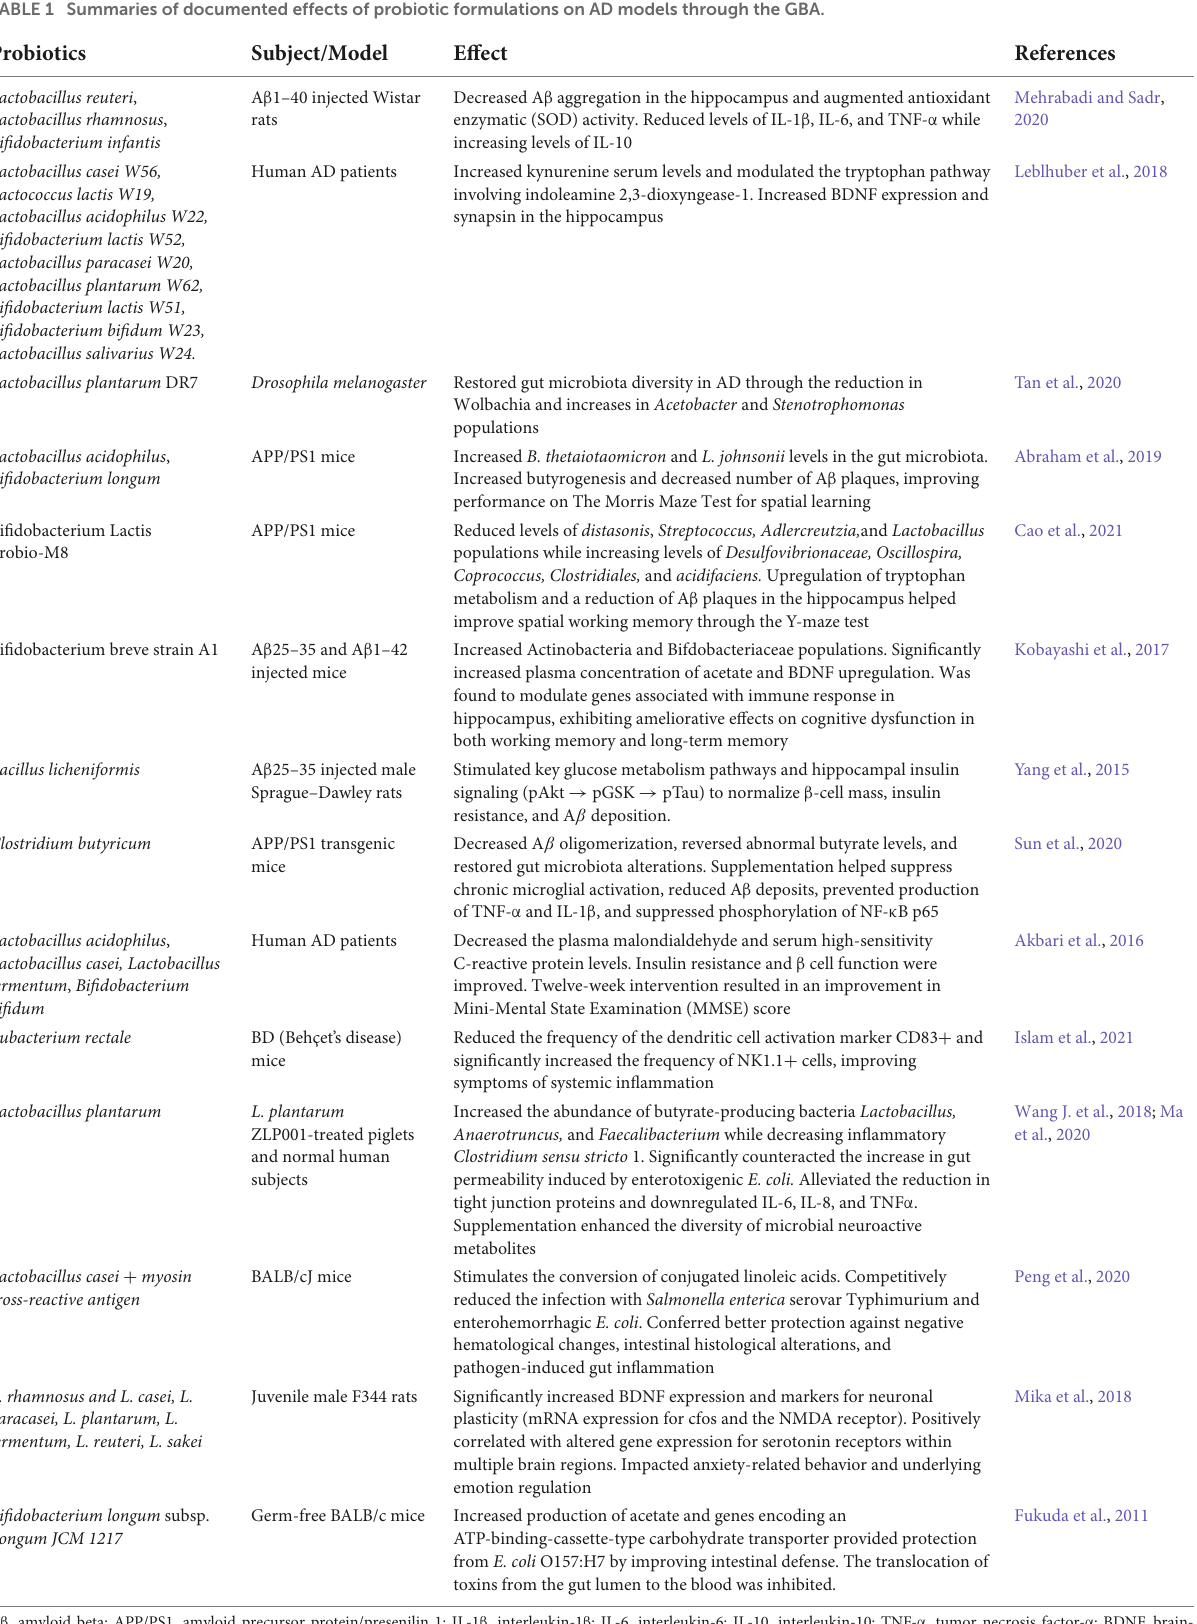
TABLE 1 Summaries of documented effects of probiotic formulations on AD models through the